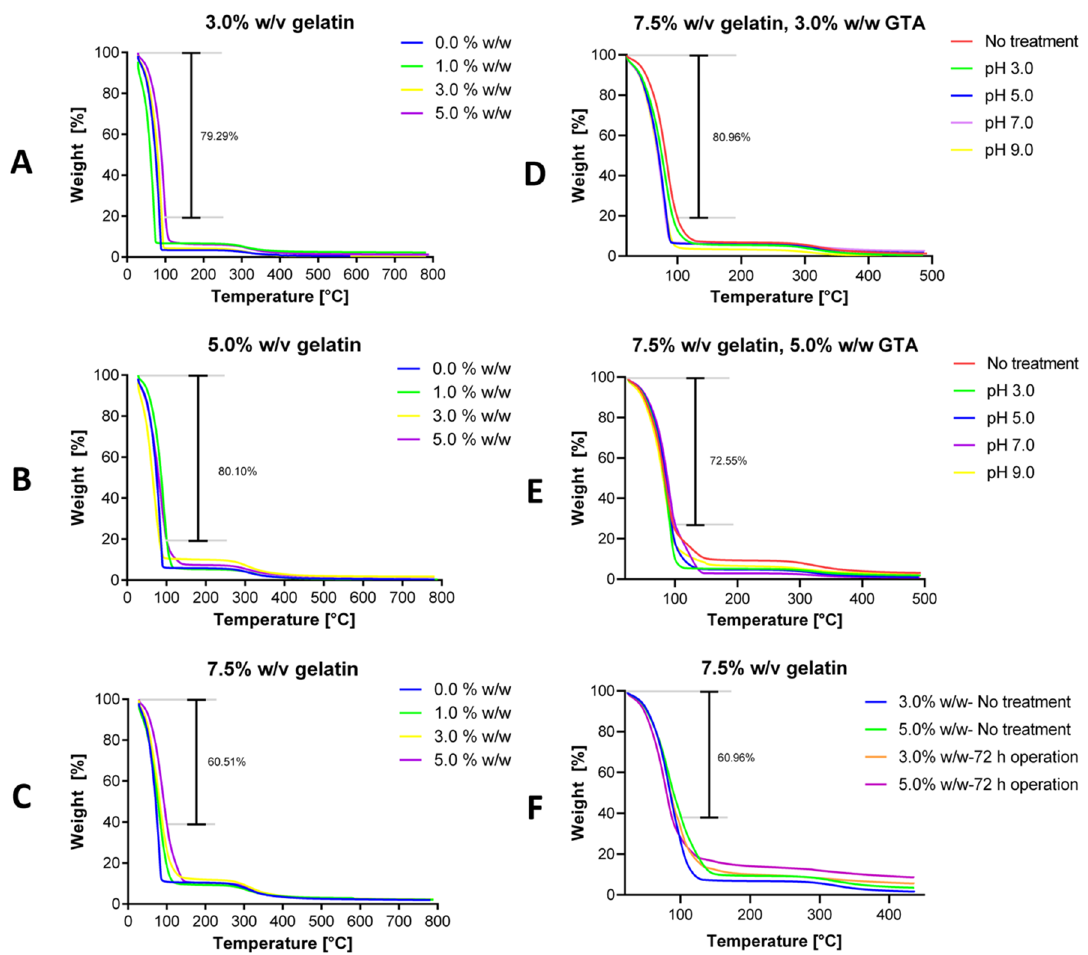
Figure 9. The minimum weight (%) loss at 100 °C is indicated on each plot. Thermograms for hydrogels with 3.0% ( A ), 5.0% ( B ) and 7.5% ( C ) ( w/v ) gelatin concentration. GTA concentrations of 0.0% ( w/w ) (blue), 1.0% ( w/w ) (green), 3.0% ( w/w ) (yellow) and 5.0% ( w/w ) (purple). Thermal degradation after exposure to different pH media for 3.0% ( D ) and 5.0% ( w/w ) ( E ) GTA hydrogels and after the milli-bioreactor operation ( F ).